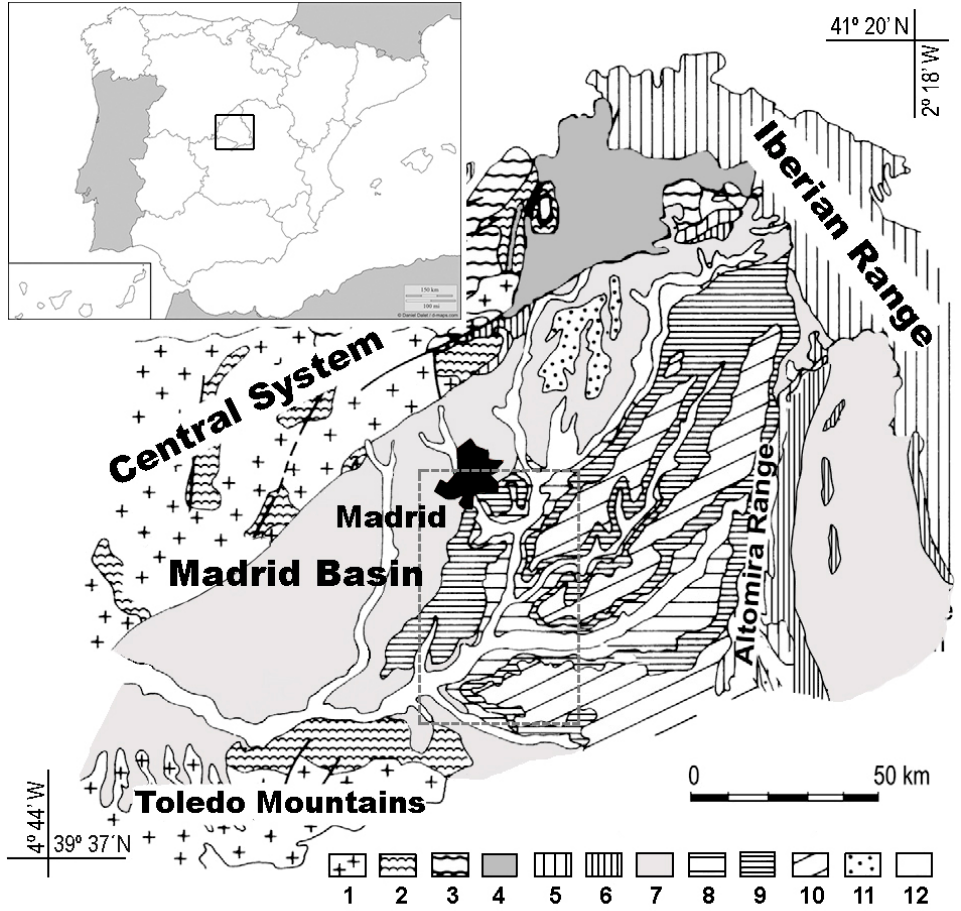
Figure 1. Geological scheme of the Tajo Basin. Variscan basement: 1, granite and granitoids; 2, high-grade metamorphic rocks; 3, medium-grade metamorphic rocks; 4, low-grade metamorphic rocks. Mesozoic cover: 5, Cretaceous and Jurassic carbonate rocks. Cenozoic: 6, Paleogene detrital and gypsum rocks; 7, Neogene arkosic materials; 8, Miocene lower unit; 9, Miocene intermediate unit; 10, Miocene upper unit; 11, Pliocene; 12, recent sediments. Modified from Reference [63].